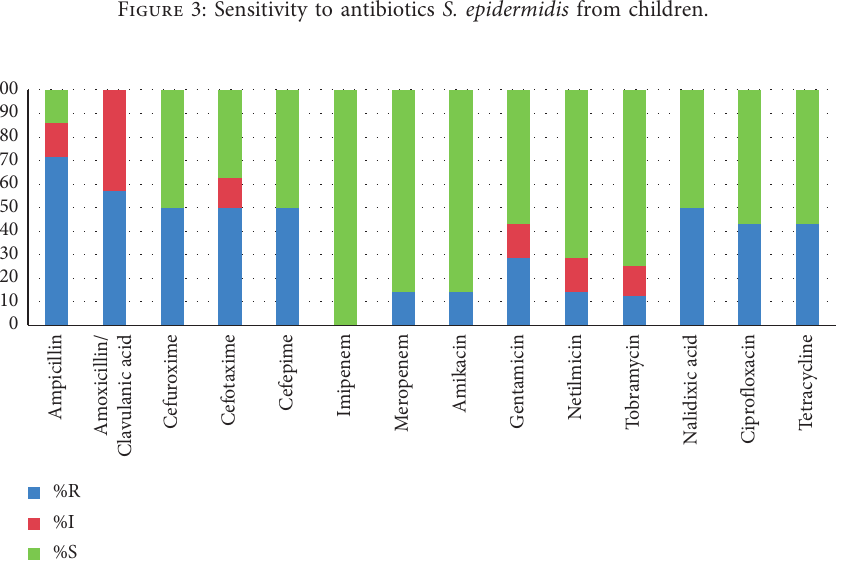
Figure 4: Sensitivity to antibiotic Enterobacterales strains from adults.